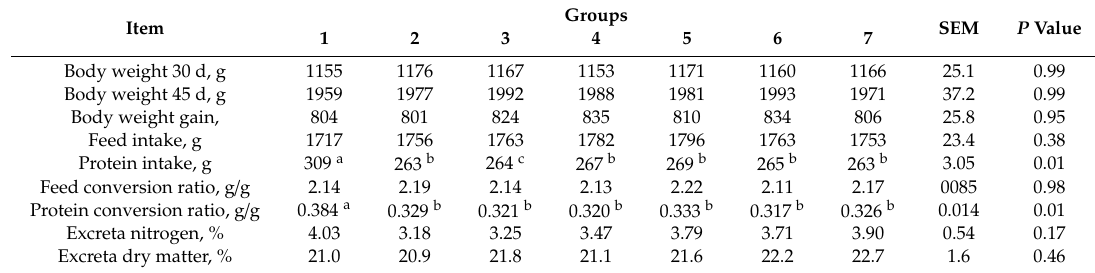
Table 3. Growth performance from 30 to 45 day of age (Trial 2).